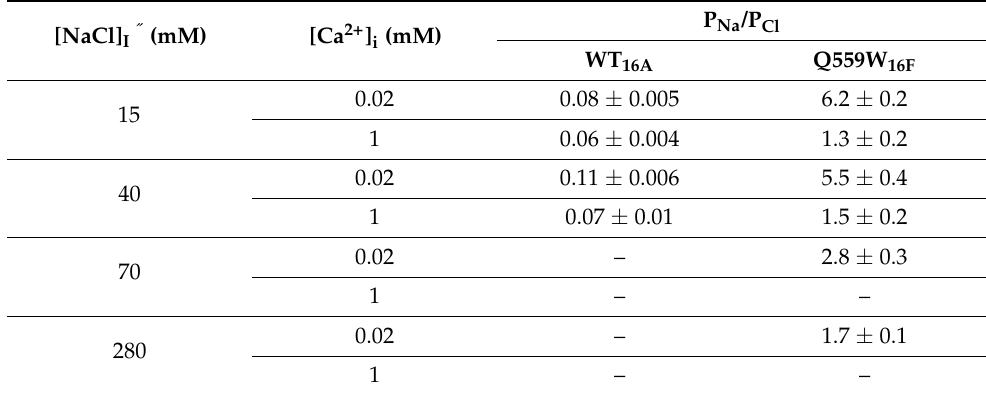
Table 1. Calculated P Na / PCl of WT 16A and Q559W